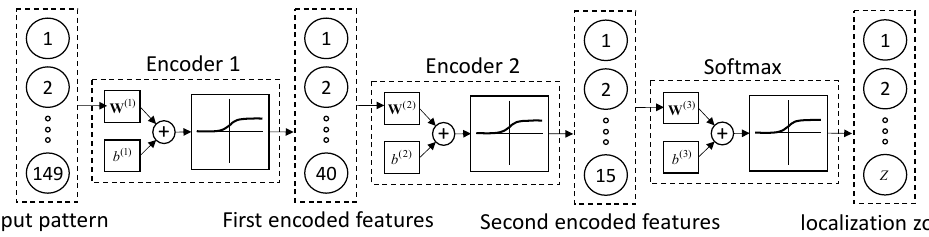
Figure 5. A stack of two autoencoders and a softmax layer. This architecture is used to find the zone in which an AE source occurs.